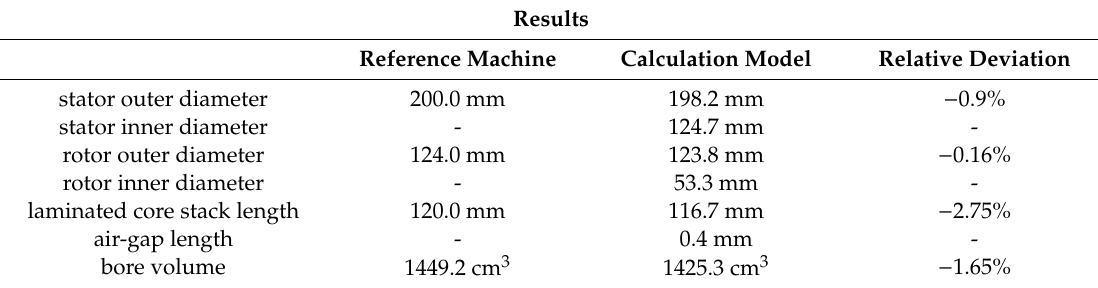
Table 5. Input parameters for validation of main dimensions—Renault